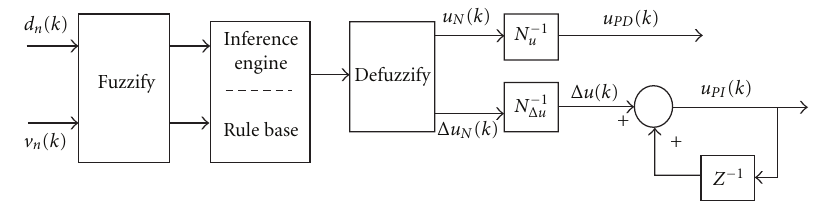
Figure 2: Block diagram of a typical fuzzy PI/PD controller.